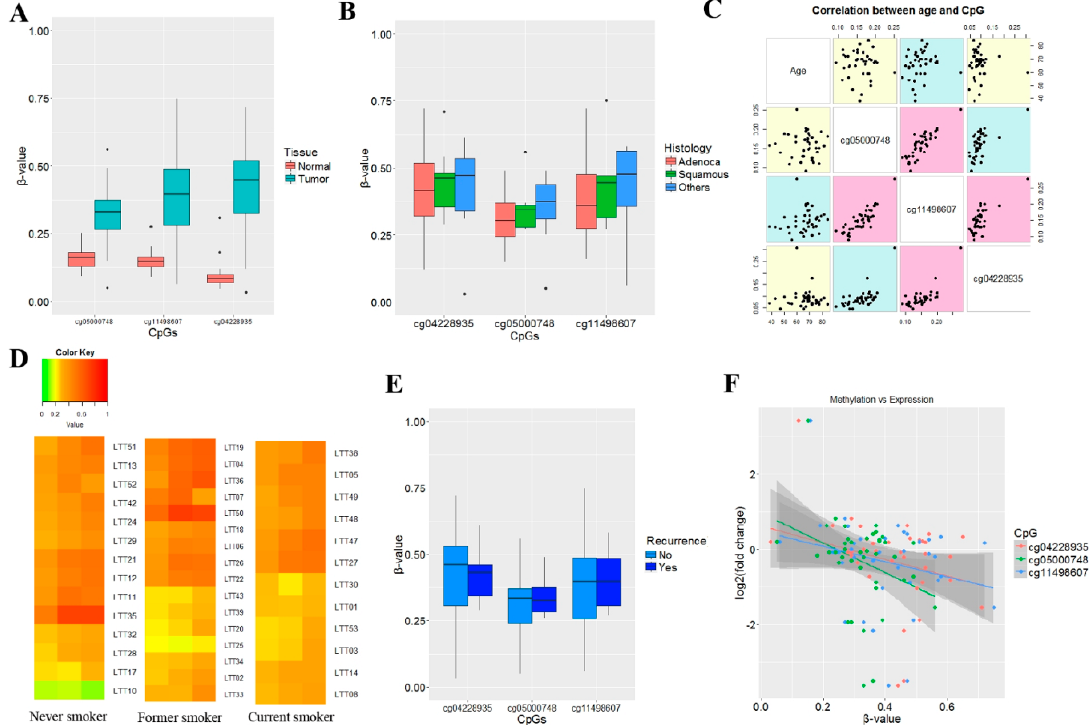
Figure 1. Relationship between methylation and mRNA levels of runt-related transcription factor 1 ( RUNX1) in 42 lung tumor and matched normal tissues. ( A ) Methylation levels of three CpGs at the CpG island of RUNX1 gene were compared between the tumor and matched normal tissues obtained from 42 NSCLC patients. Y-axis indicates β -values. ( B ) Methylation levels of the three CpGs were compared according to histologic subtypes. ( C ) Correlations between the patient’s age and the methylation levels of the three CpGs were analyzed in 42 tumor tissues. Spearman’s correlation coe ffi cient was used to calculate p -values. Magenta color indicates p < 0.05. ( D ) Methylation levels of three CpGs at a CpG island of RUNX1 were compared in never-smokers, former smokers, and current smokers. Y-axis indicates sample identification numbers. Methylation levels are represented using gradient-based colors from green (0%–20%) to yellow (21%–50%) to red (51%–100%). ( E ) The association between recurrence and the methylation levels at three CpGs were analyzed in 42 NSCLCs. ( F ) The correlation between methylation levels of three CpGs and the mRNA expression of RUNX1 was analyzed in 42 tumor tissues from patients with NSCLC. Y-axis indicates the log2 fold change ( = log2(tumor / normal)) between tumor and matched normal tissues. X-axis indicates β -values in tumor